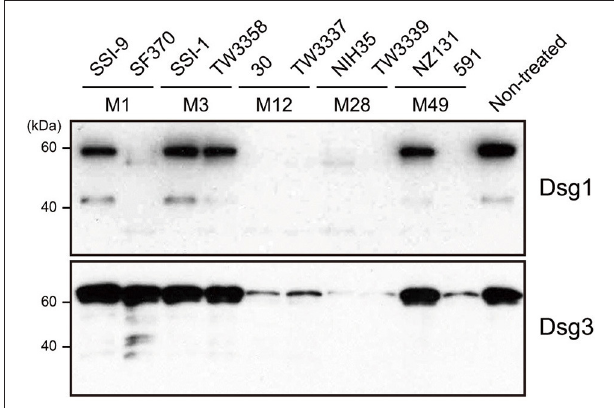
FIGURE 1 | S. pyogenes culture supernatants induce cleavage of Dsg1 and Dsg3. Recombinant extracellular domains of Dsg1 and Dsg3 were separately incubated with culture supernatants from S. pyogenes clinical isolates for 3h at 37 ◦ C. Sample proteins were separated by SDS-PAGE under a reducing condition, and subjected to western blot analysis using specific antibodies against the extracellular domain of Dsg1 and Dsg3.